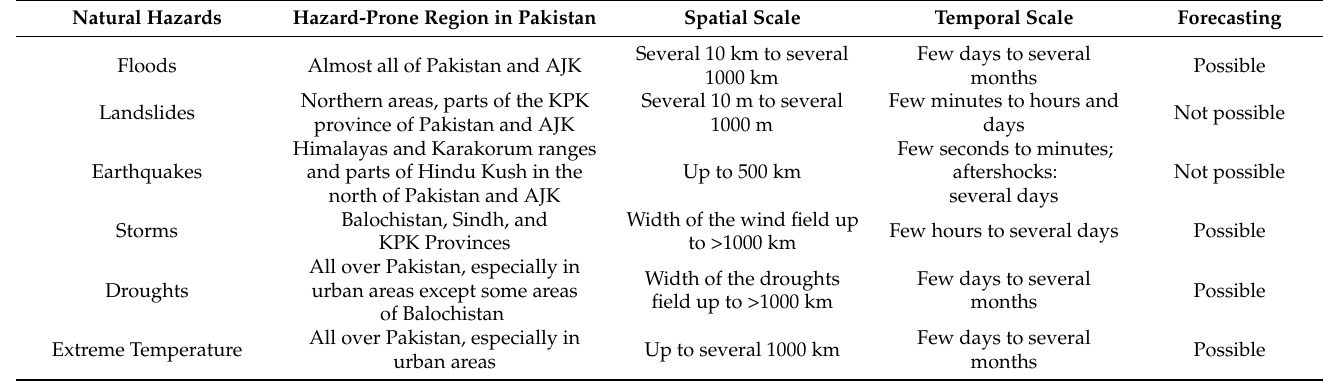
Table 2. Spatial-temporal characteristics of critical natural hazards in Pakistan (Data source: NDMA, PMD, PDMAs, SPARCO, and L. Rafiq and T. Blaschke